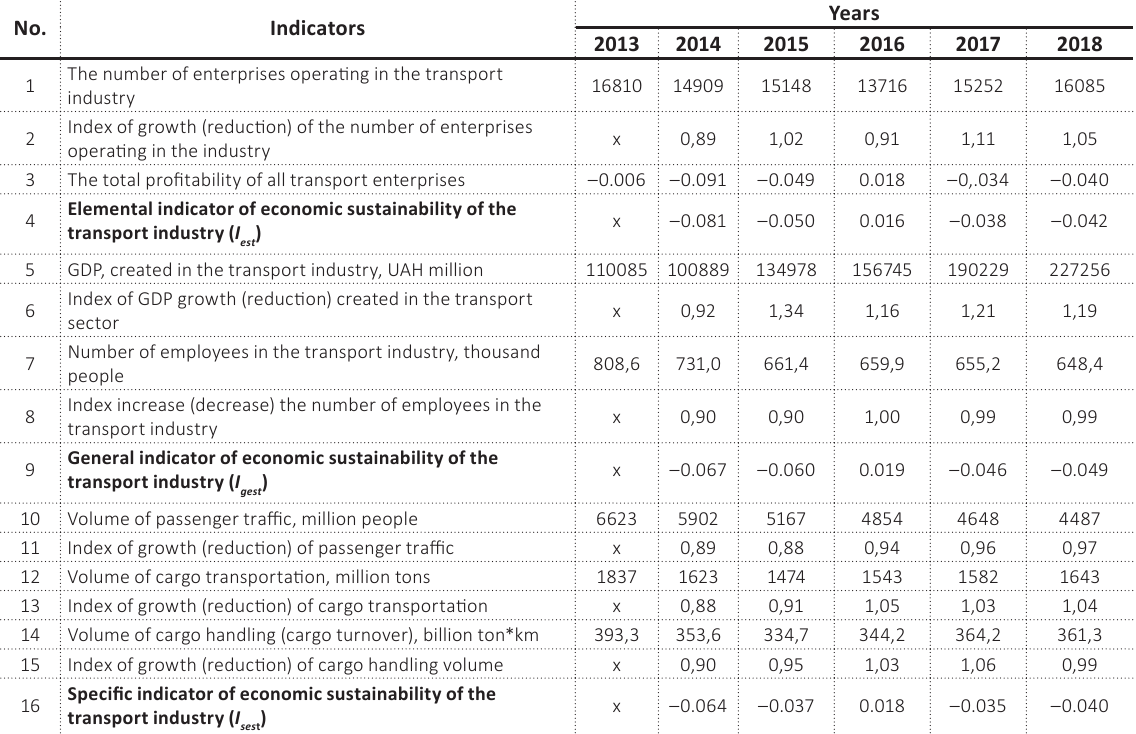
Table 2. Dynamics of indicators of economic sustainability of transport industry of Ukraine for